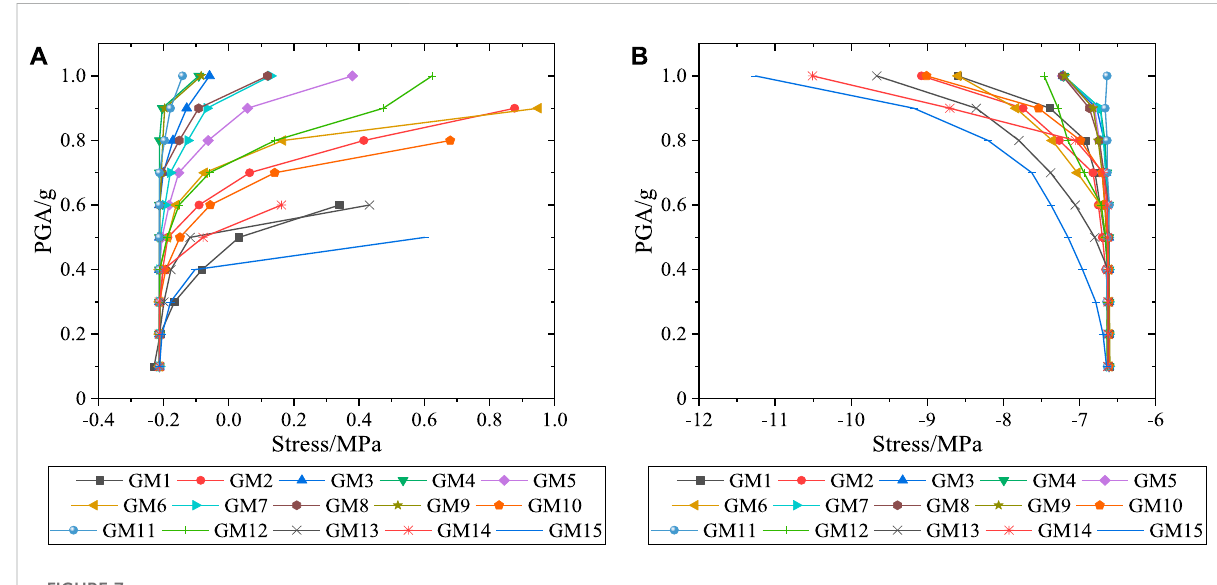
Base isolated layer: (A) Maximum vertical stress, (B) Minimum vertical stress.